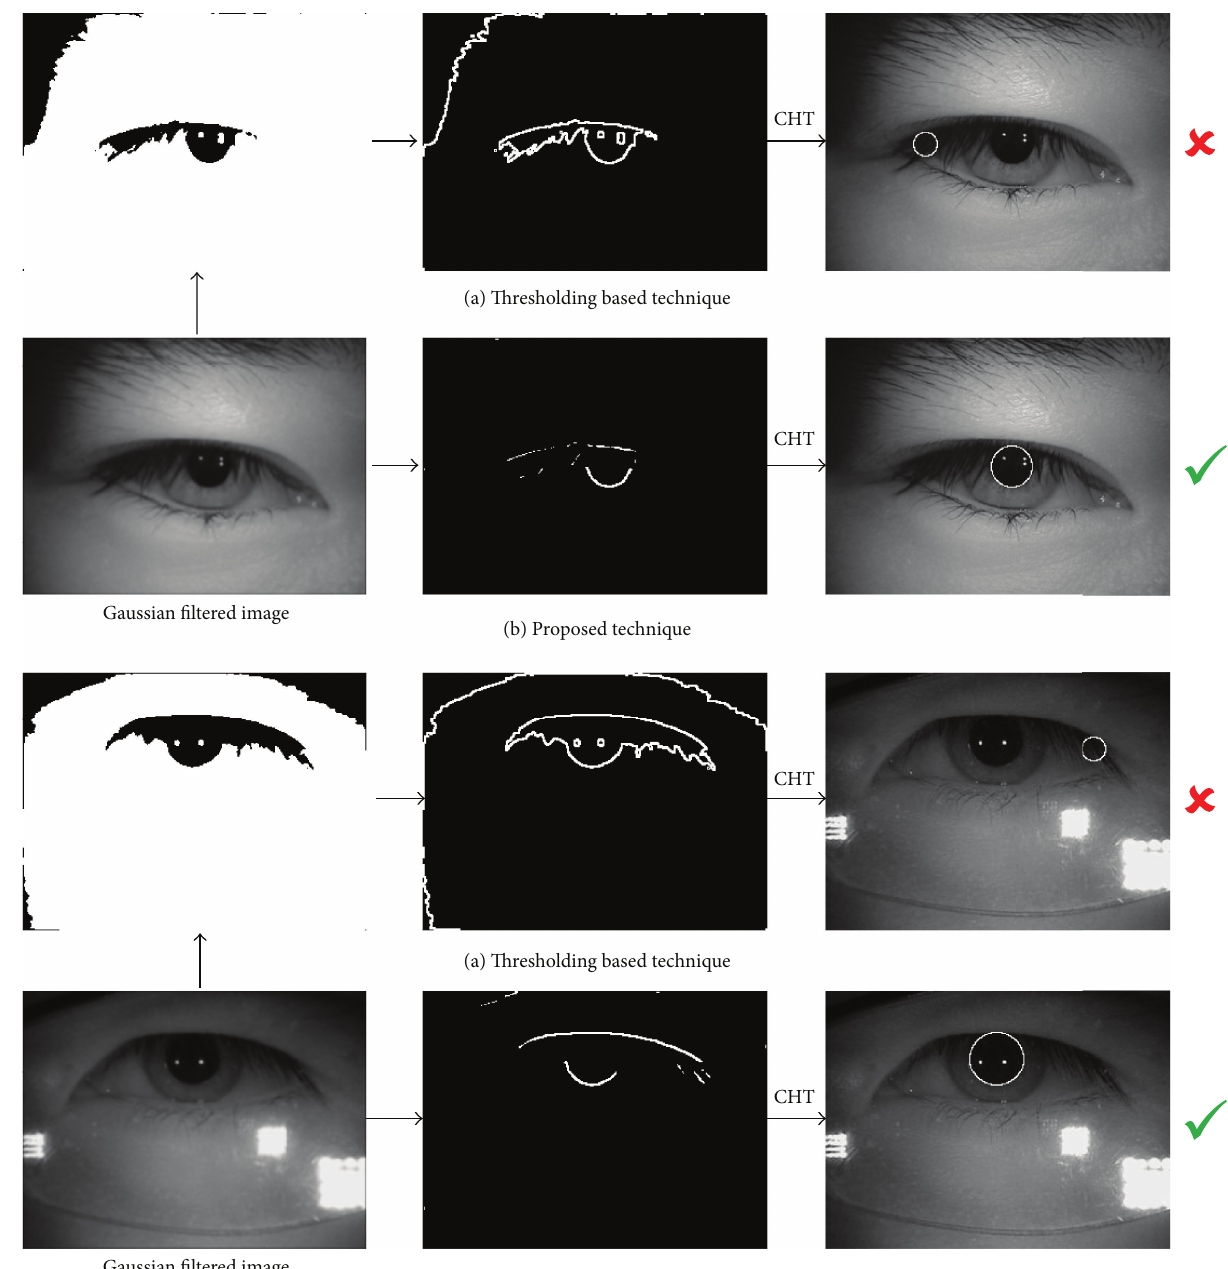
Figure 6: Examples of wrong pupil localization using thresholding based technique, which is corrected by the proposed